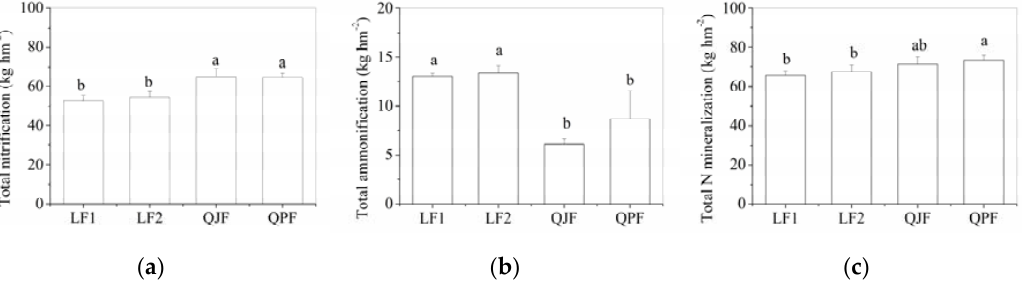
Figure 4. Differences of soil total cumulative nitrification ( a ), ammonification ( b ) and N mineralization ( c ) in various forest types from May to November. Different letters indicate significant differences among forest types (adjusted p < 0.05, n = 3).